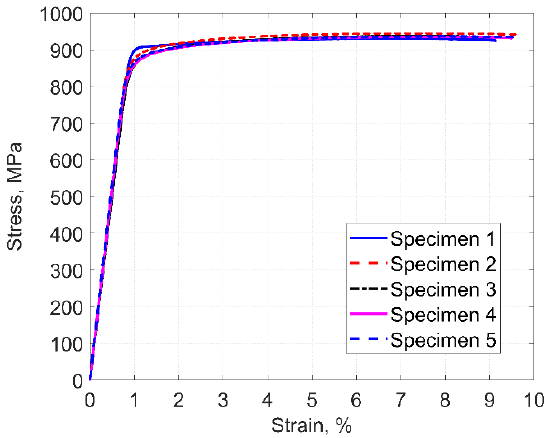
Figure 1. Tensile test setup with the additively manufactured structure using Ti6Al4V.